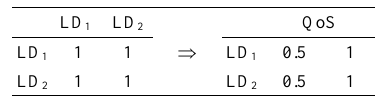
Table 11. Comparative matrix, relative weights and rankings of the criteria